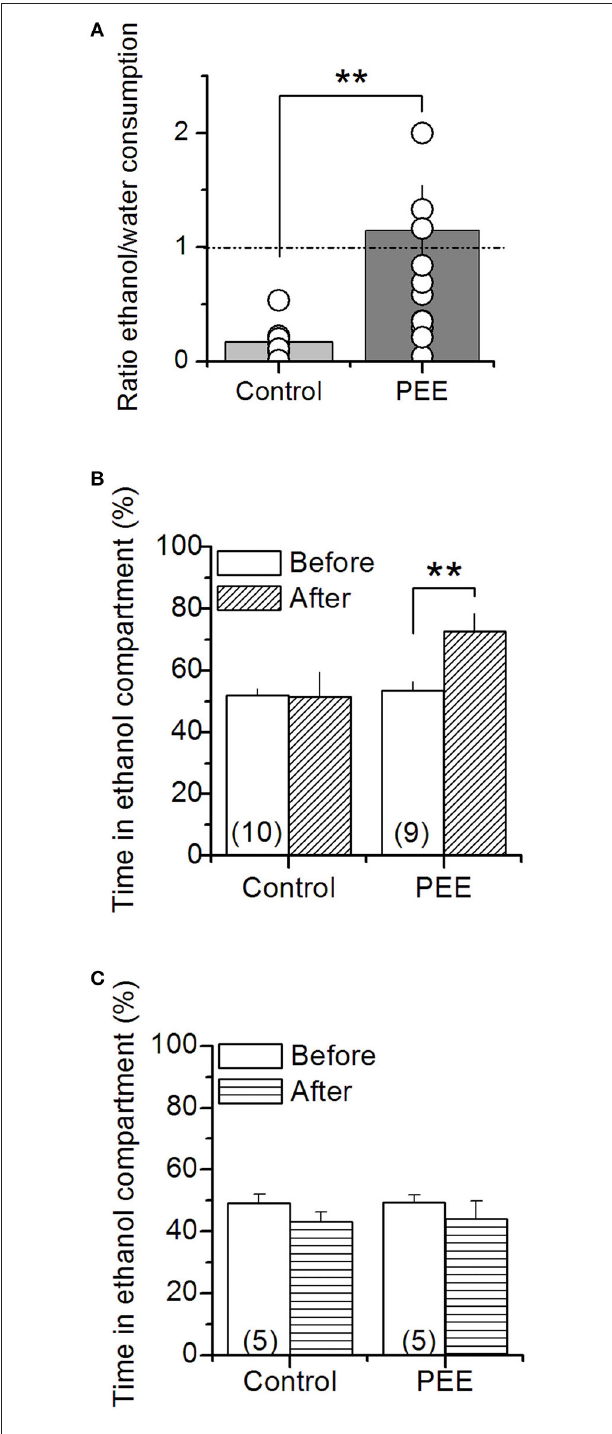
FIGURE 1 | Ethanol consumption and ethanol-dependent conditioning in control and PEE rats. (A) Free choice of ethanol (10%) solution or water consumption was measured for 24h in male rats. The graph shows the ratio between ethanol and water consumption, each point corresponds to one litter. Ethanol conditioning place preference was measured in male (B) and female (C) rats. N is indicated into the bars. ** P < 0.01 (unpaired Student’s t